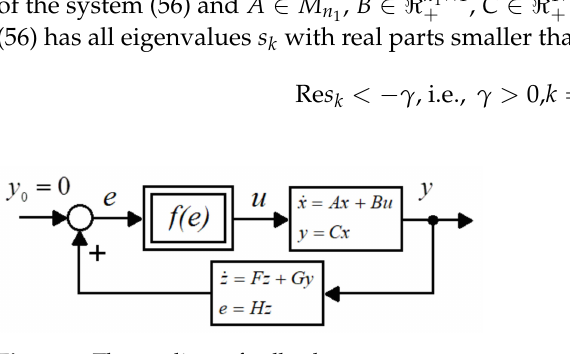
Figure 3. The nonlinear feedback